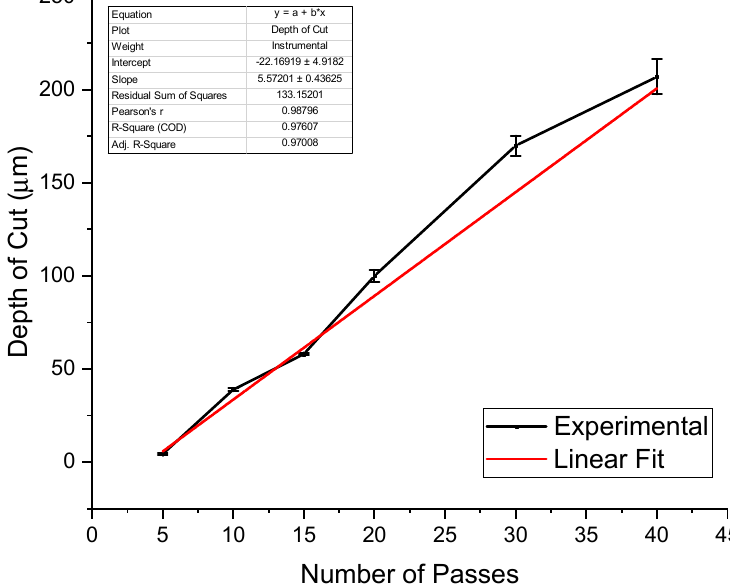
Figure 8. Results from scribing lines in PDMS with a varied number of laser passes. The depth of cut increases linearly with the number of laser passes as expected. This allows for the direct tuning of microchannel depth by selecting the number of passes the laser makes in order to cut PDMS.